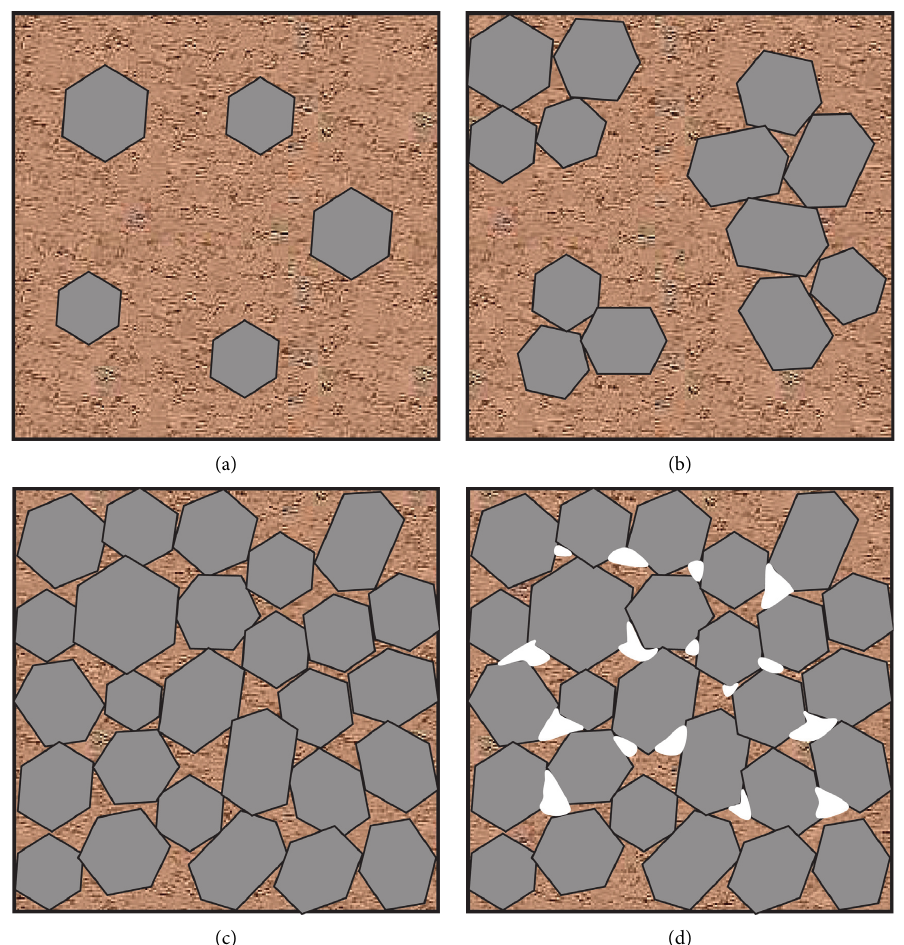
Figure 13: Four typical rock skeleton structures. (a) Rock-float skeleton. (b) Rock-part skeleton. (c) Rock-complete skeleton. (d) Rock-void skeleton.